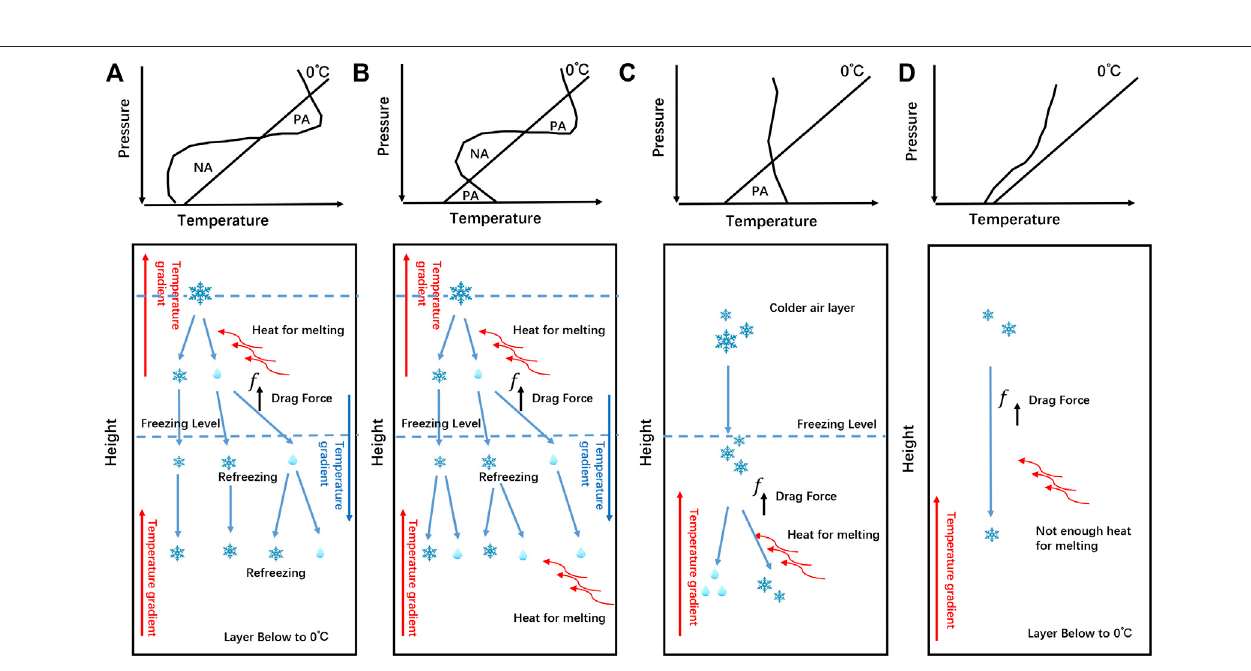
FIGURE 8 | Schematic diagram illustrating the formation of the different precipitation types under the four typical vertical temperature pro fi les. Plots A-D are adapted from Bourgouin (2000). The positive (PA) and negative (NA) areas indicate the above and below freezing layers, respectively.